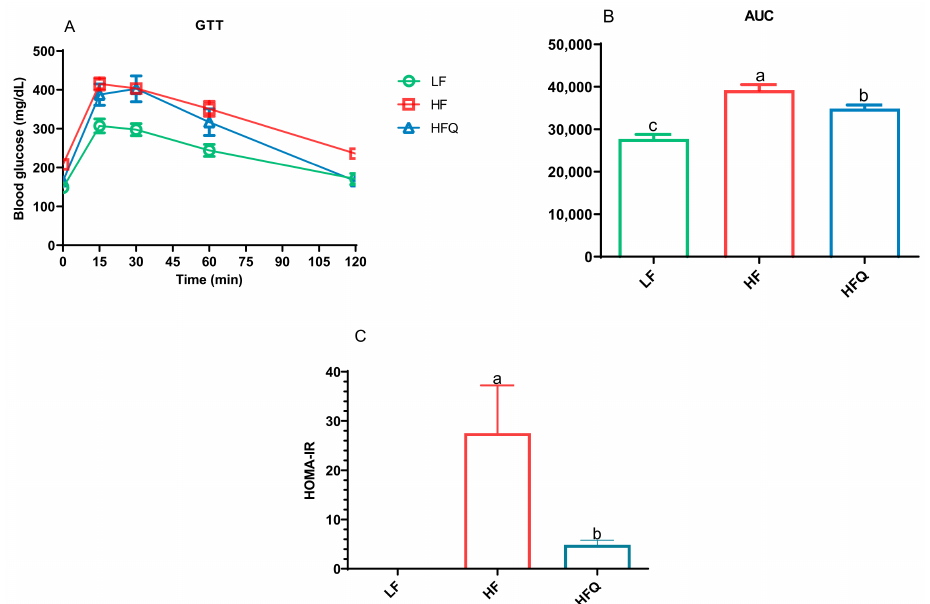
Figure 3. ( A ). Glucose tolerance in mice fed a high-fat (HF) diet, high-fat diet containing 0.05% quercetin (HFQ), and low-fat (LF) diet for 6 weeks. ( B ). Area under glucose tolerance test (GTT) curve values. ( C ). Homeostatic model assessment of insulin resistance (HOMA-IR) index of HF and HFQ diet-fed mice; the HOMA-IR index for the LF group was 0. Data are expressed as means ± SEMs, n = 8/group. Bars with different letters were significantly different ( p < 0.05).